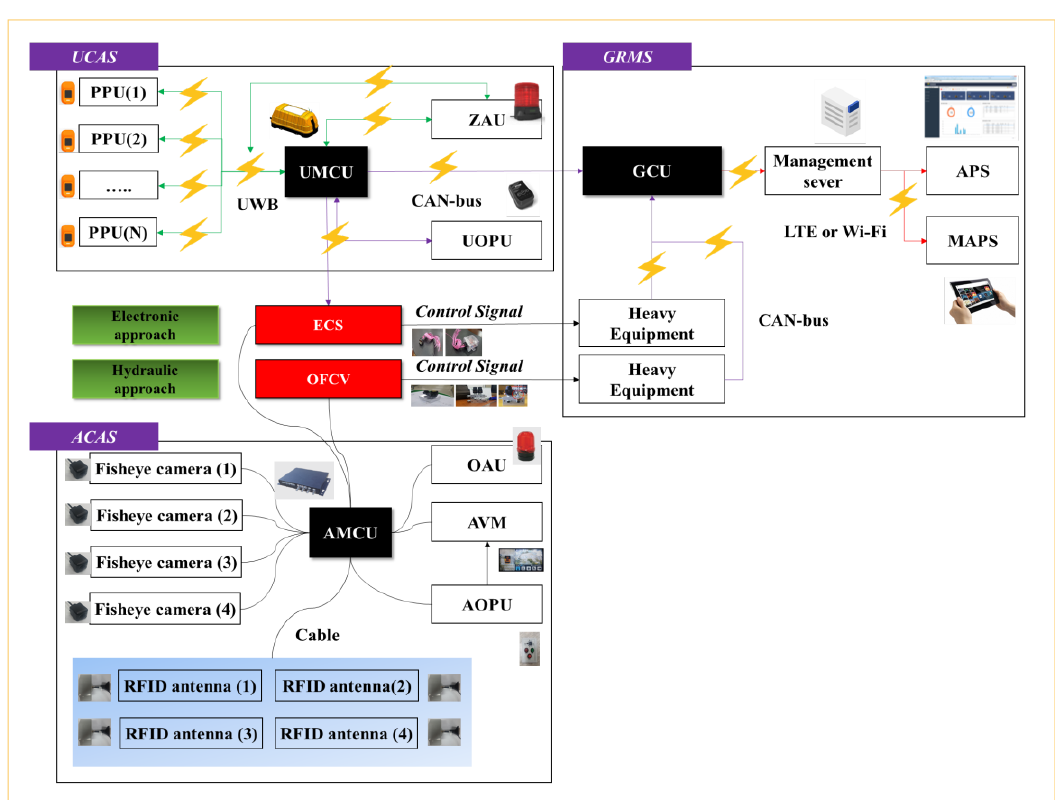
Figure 2. Overall hardware-software block diagram of RCSS.